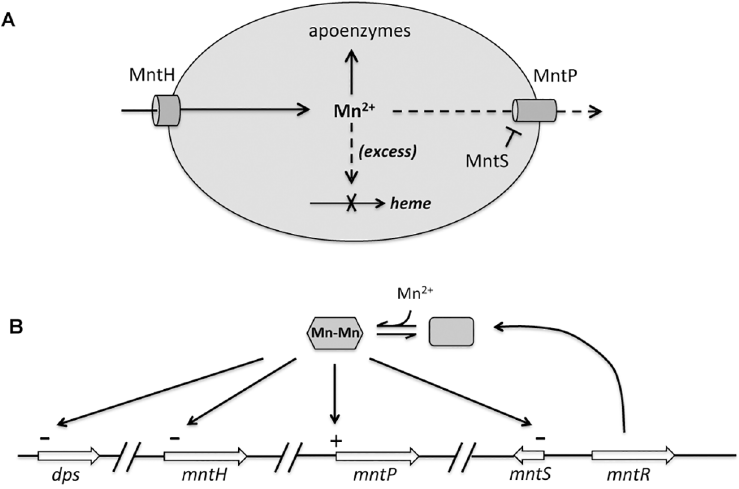
Fig 12. Proposed model of the MntR regulon. A. When expressed, MntH provides sufficient manganese for enzyme metallation. Excessive manganese (dashed lines) potentially inhibits heme synthesis at the ferrochelatase step, and so induction of MntP is needed to export manganese. When manganese levels fall, induction of MntS inhibits MntP and maintains manganese pools. B. Transcriptional effects of manganese- loaded MntR. The mntH gene is additionally repressed by iron-loaded Fur, and both it and dps are induced by H 2 O 2 -oxidized